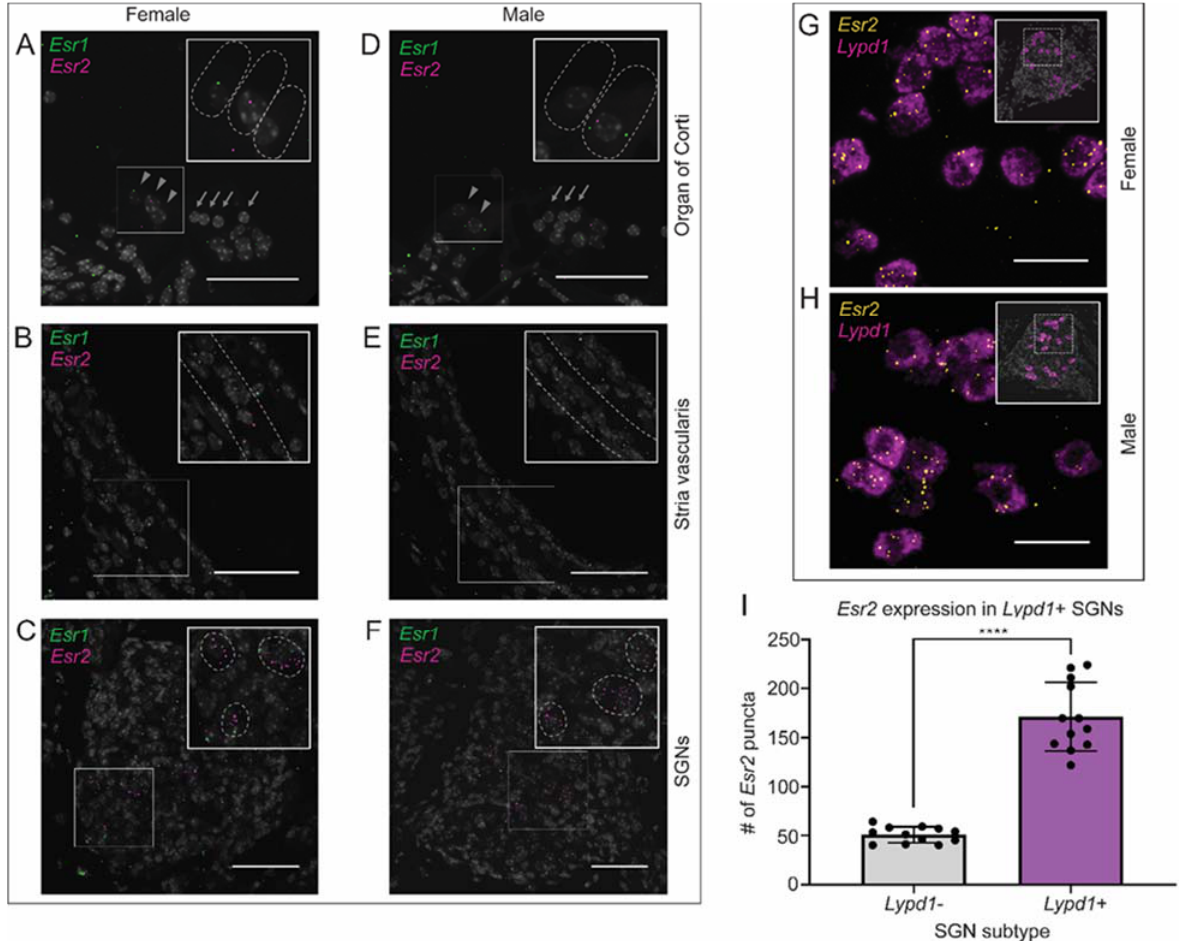
Figure 8. Fluorescent in situ hybridization of estrogen receptor 1 ( Esr1 ) and estrogen receptor 2 ( Esr2 ). mRNA expression in the organ of Corti, stria vascularis, and spiral ganglion neurons of both male and female mice ( A – F ). Esr1 (green puncta) and Esr2 (magenta puntca) are present at low levels in the inner hair cells of the organ of Corti, marked by grey arrowheads, but are absent in the outer hair cells, marked by grey arrows ( A , D ). Esr1 is expressed throughout the three cell layers of the stria vascularis, while Esr2 expression appears highest in the basal cell layer, marked by dashed grey lines ( B , E ). Esr1 expression is low and diffuse within the spiral ganglion neurons, while Esr2 expression appears highest in a specific neuronal subtype ( C , F ). Scale bars: 50 μ m. ( G , H ) Esr2 , represented by yellow punctate dots, is co-expressed with Lypd1 , a type-1C SGN marker seen in magenta. ( I ) Esr2 expression is highest in type-1C SGNs compared to any other cell type in the spiral ganglion ( **** p < 0.0001; student’s t-test). Scale bars: 25 μ m.